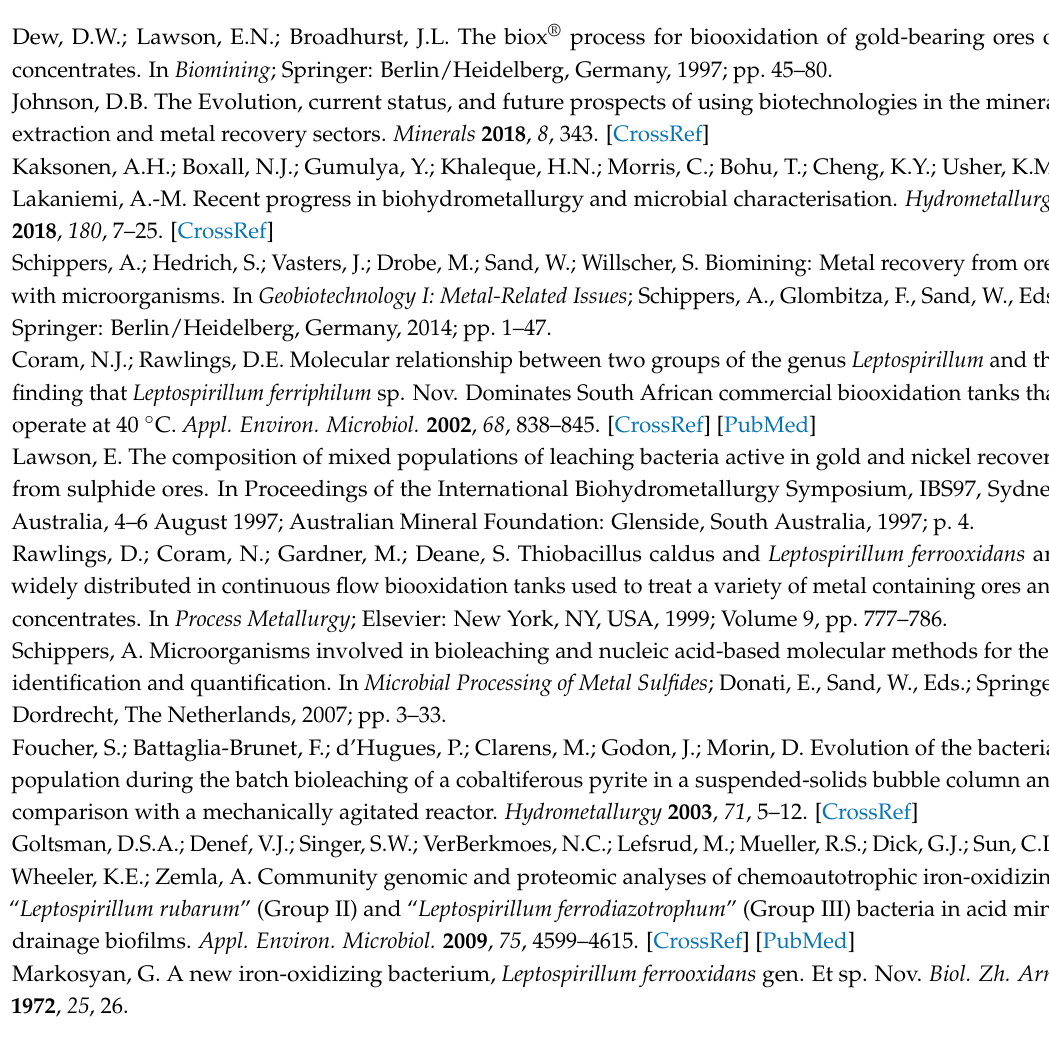
Figure S1: Sampling areas in different biotopes of sulfide ores in